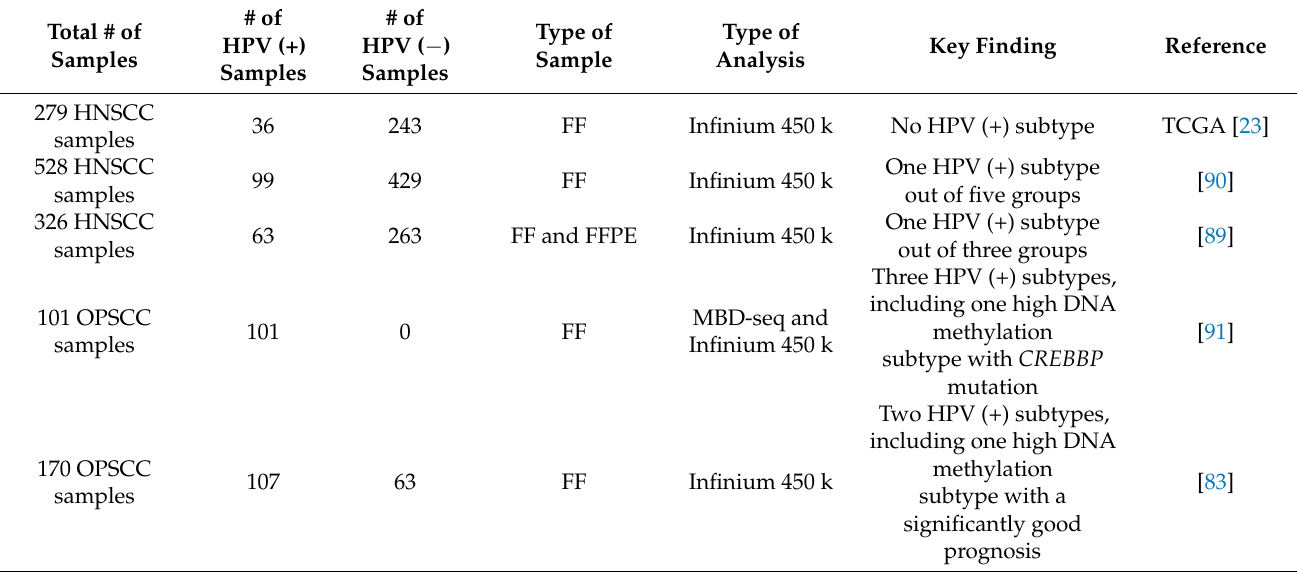
Table 3. Comprehensive large-cohort DNA methylation analysis at a genome-wide scale using human papillomavirus (HPV)-associated head and neck squamous cell